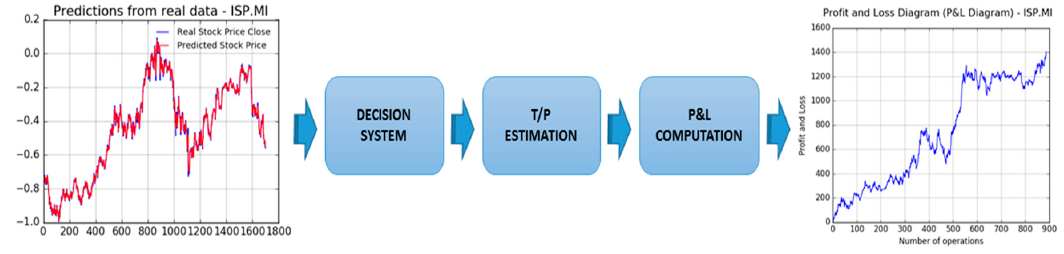
Figure 6. Trading System Pipeline.